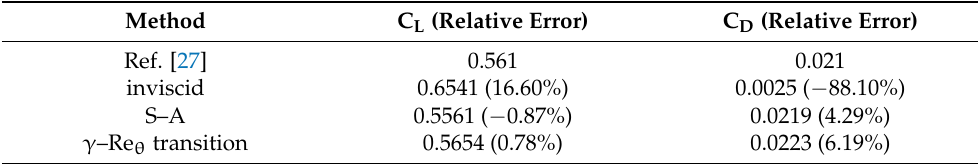
Table 1. Comparison of lift and drag coefficients by different computational methods.